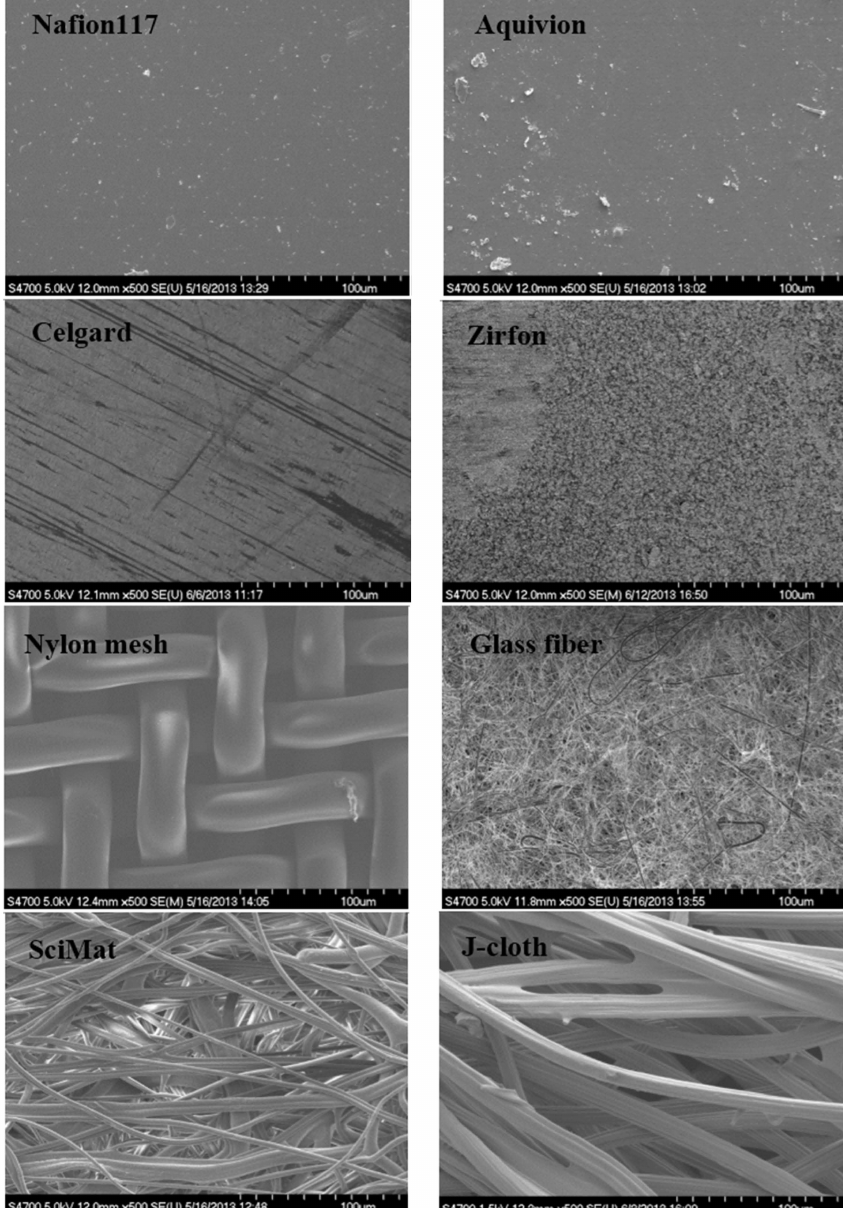
Figure 3. SEM images from the surface of the virgin (unused)